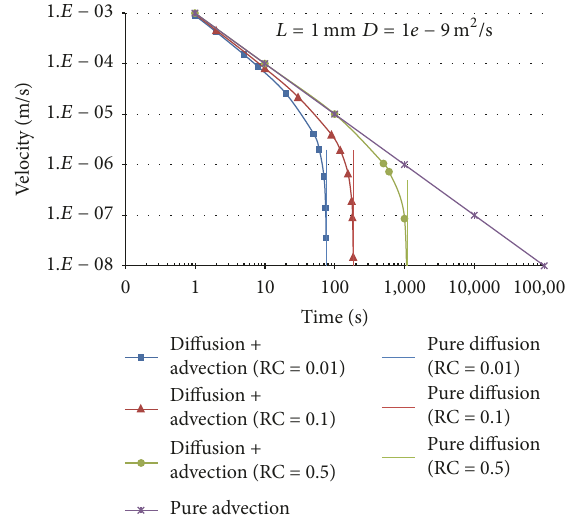
Figure 3: Mass Breakthrough Time (MBT) as a function of velocity for pure diffusion, diffusion with advection, and pure advection (analytical solution for the case with scale length of 1mm, modified from [19]).